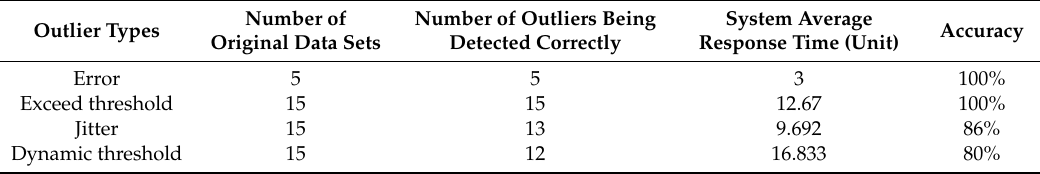
Table A1. Statistical outcomes of the experiment (sampling rate = 1 / 10 sec , network scale = 1000 nodes). Outlier Types